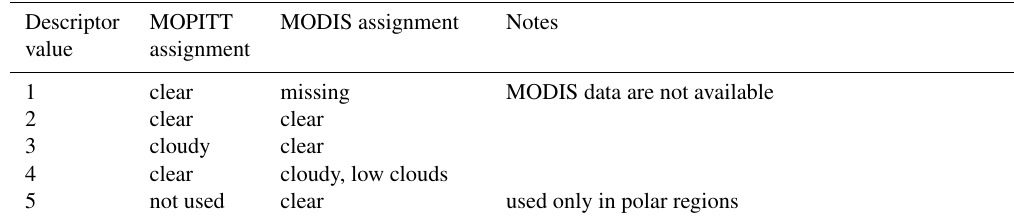
Table 1. MOPITT Cloud Descriptor Values in L2 CO retrievals.